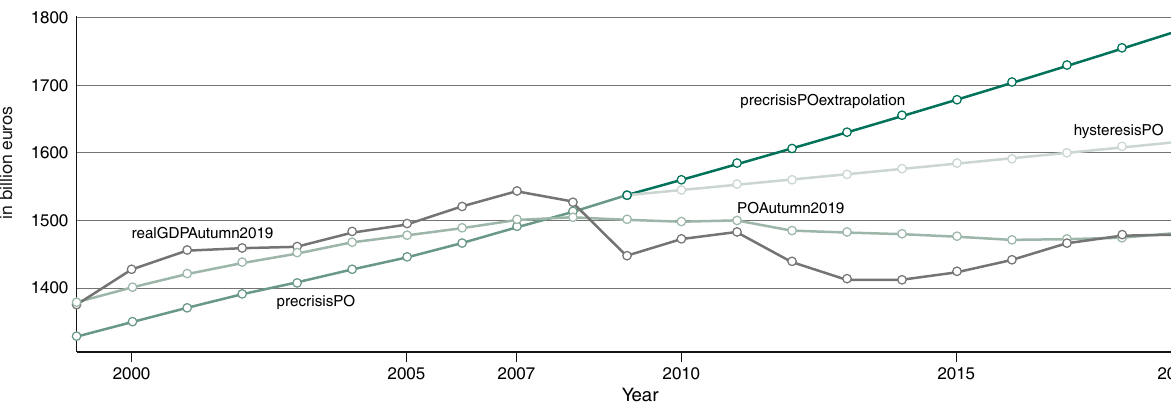
Alternative potential output estimates for Italy, 1999-2019 At constant 2005